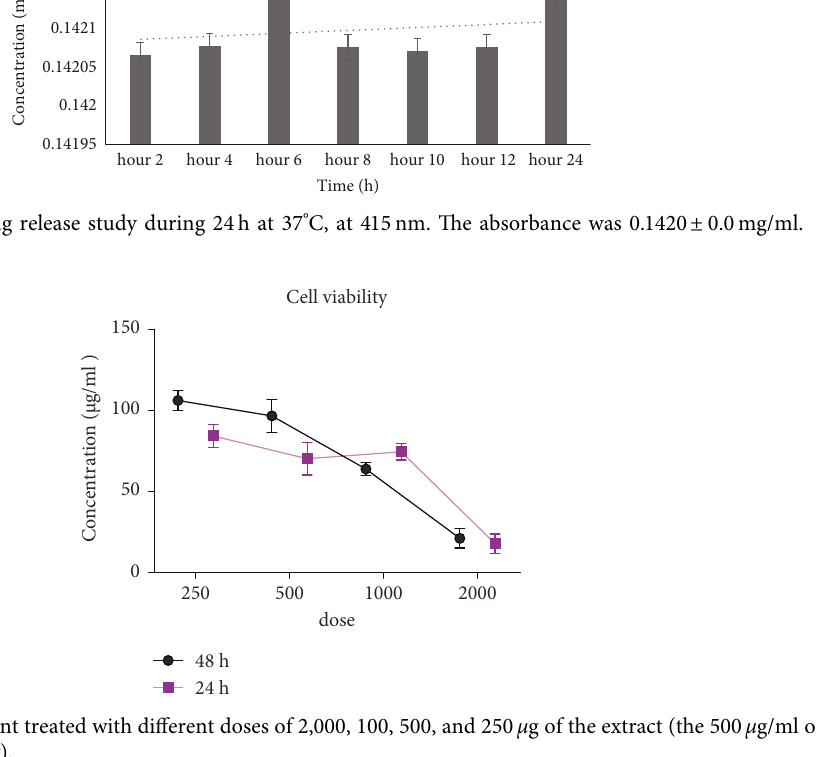
Figure 6: NHDF cell viability percent treated with different doses of 2,000, 100, 500, and 250 μ g of the extract (the 500 μ g/ml of the extract showed the maximum cell